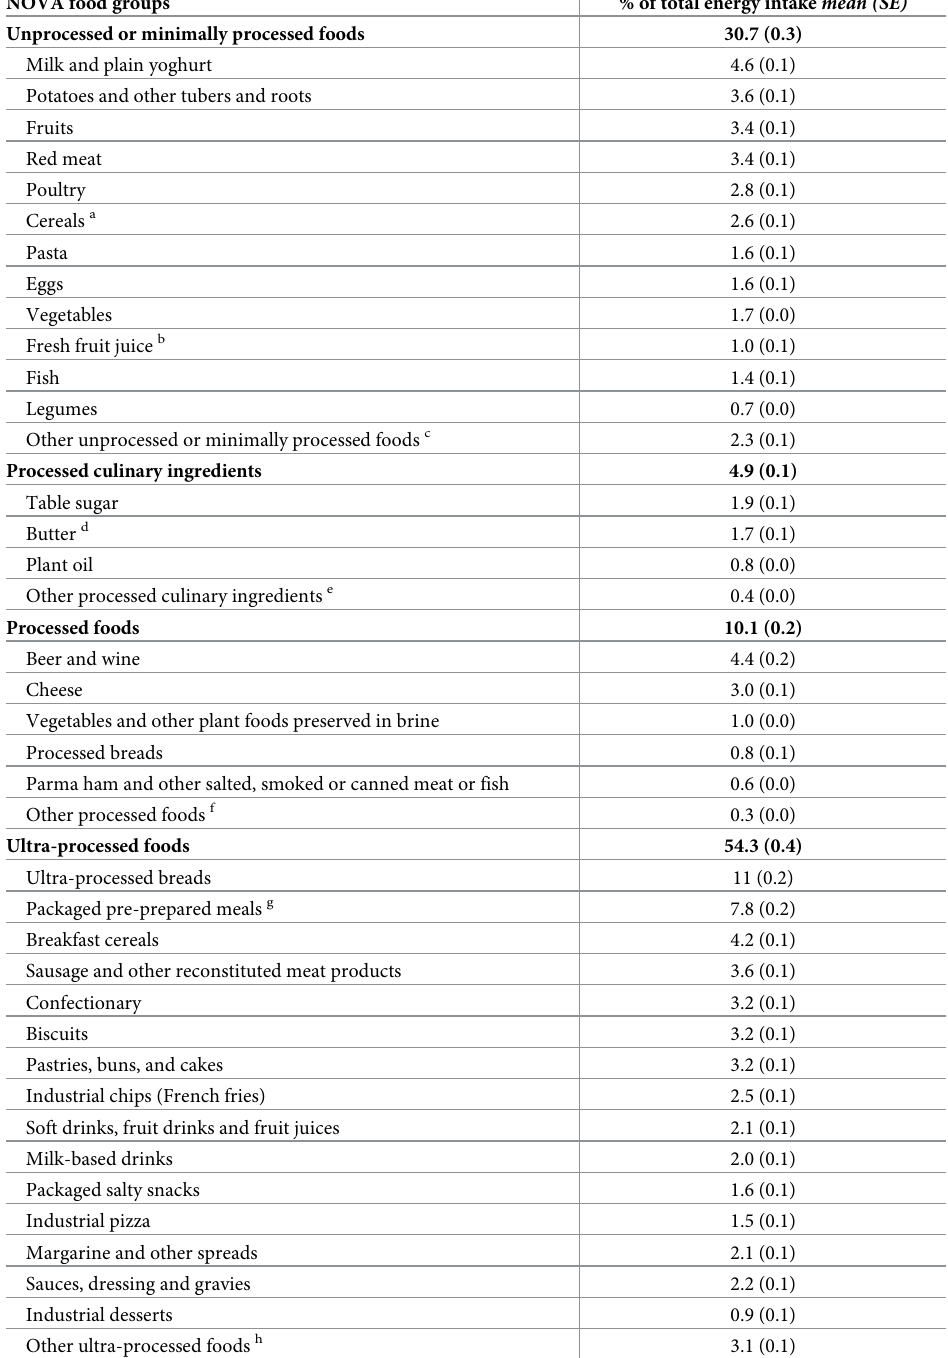
Table 1. Distribution of total energy intake according to NOVA food groups. UK population aged 19 years or over